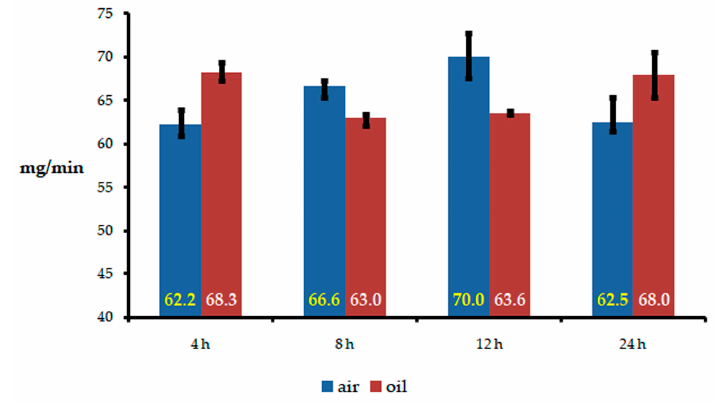
Figure 7. Resistance to erosive wear. Weight loss per unit of time.